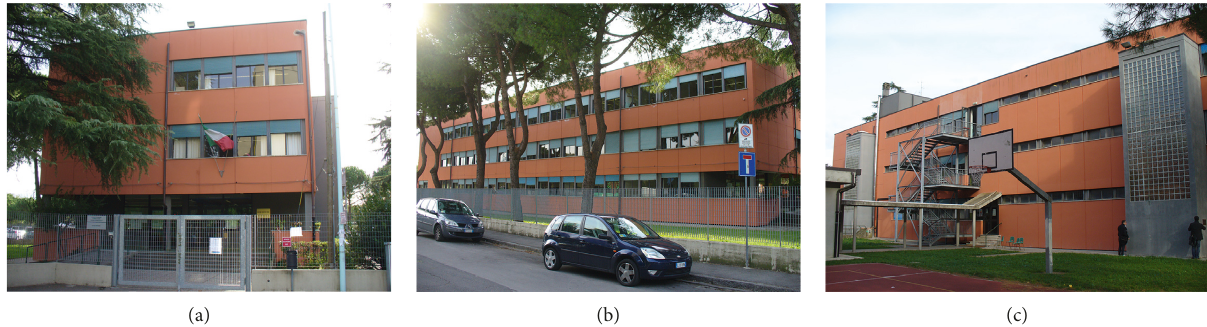
Figure 2: School building: (a) frontal elevation where the portico and the entrance hall are present; (b) and (c) longitudinal